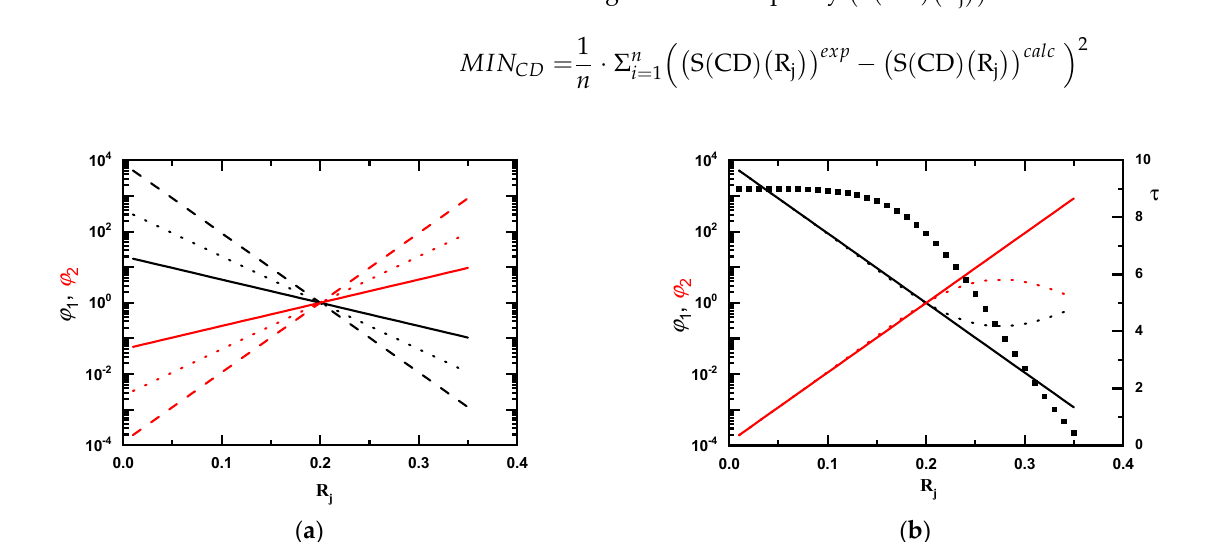
Figure 2. Dependence of ϕ 1 (Equation (8), black) and ϕ 2 (Equation (9), red) on R j . ( a ) Effect of τ equal to 3 (continuous line), 6 (dotted line), and 9 (dashed line), respectively. ( R (cid:2920)(cid:3030)(cid:3045)(cid:3036)(cid:3047) = 0.2). ( b ) Effect of constant τ ( τ = 9, continuous straight lines) or of varying τ (dotted curves) dependence of τ on R j reported on the right y-scale: ( -—- ) constant τ , ( ) variable τ .